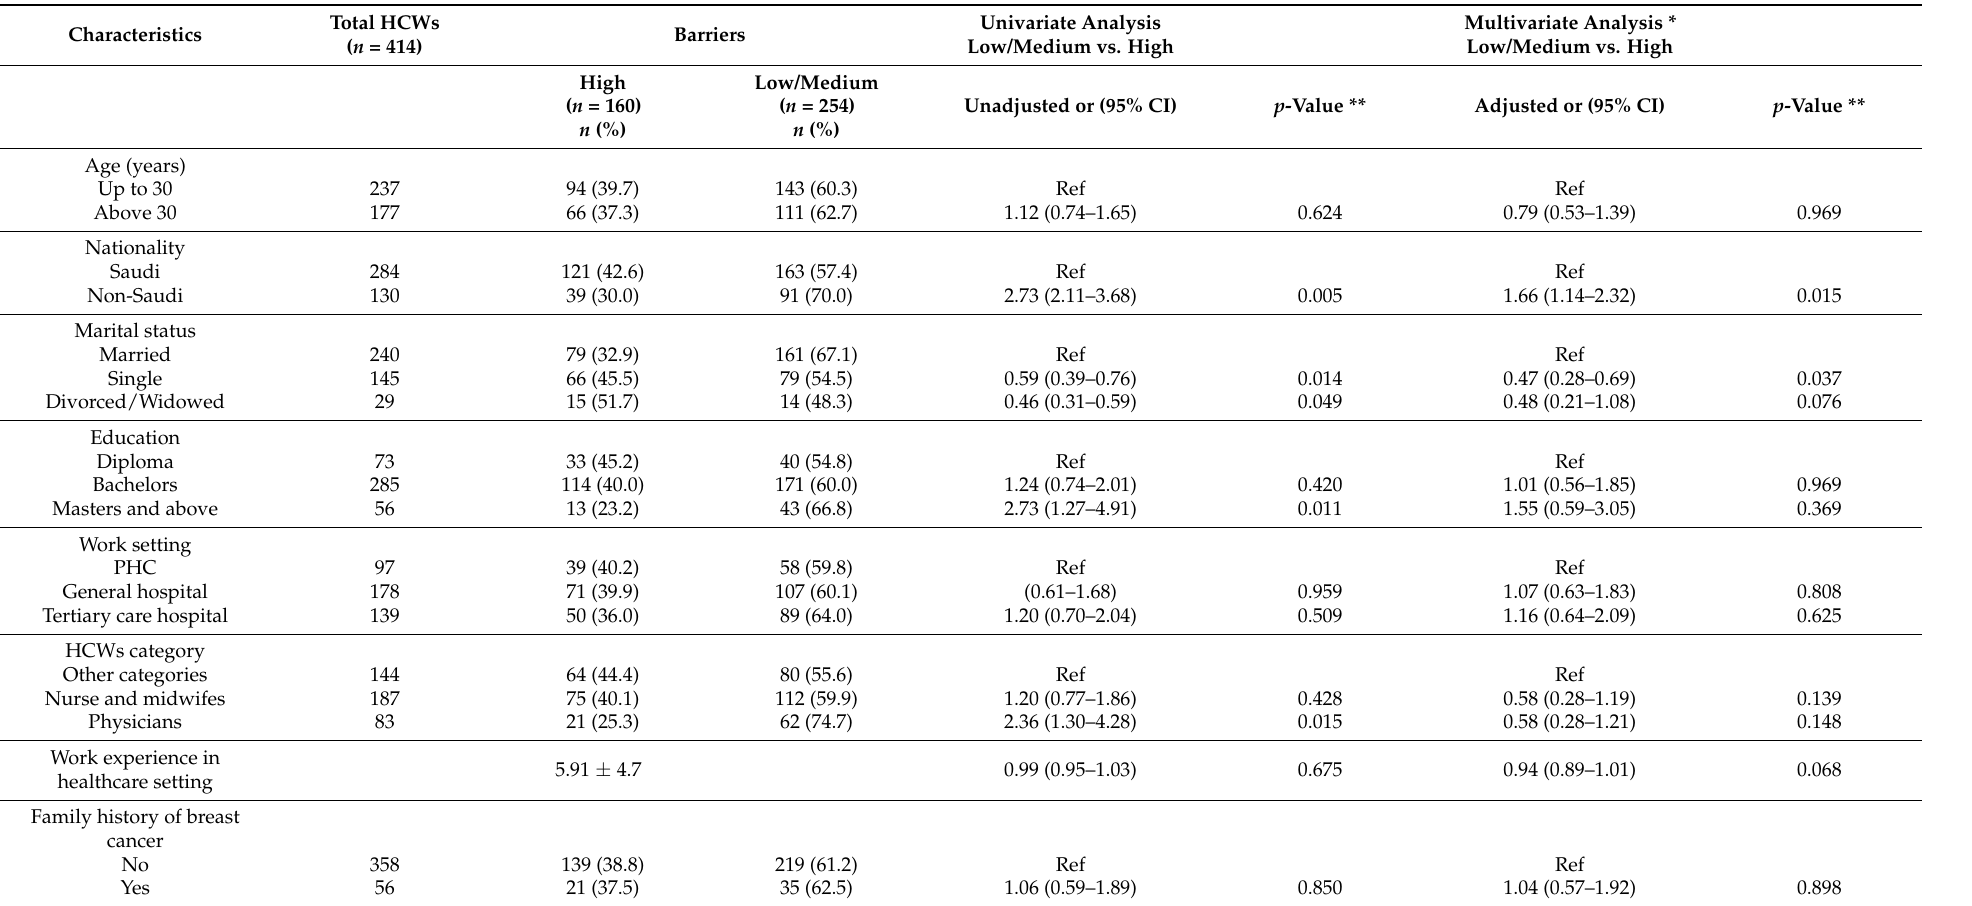
Table 6. Binomial regression analysis between participants’ socio-demographic characteristics and barriers to uptake mammogram screening ( n = 414).